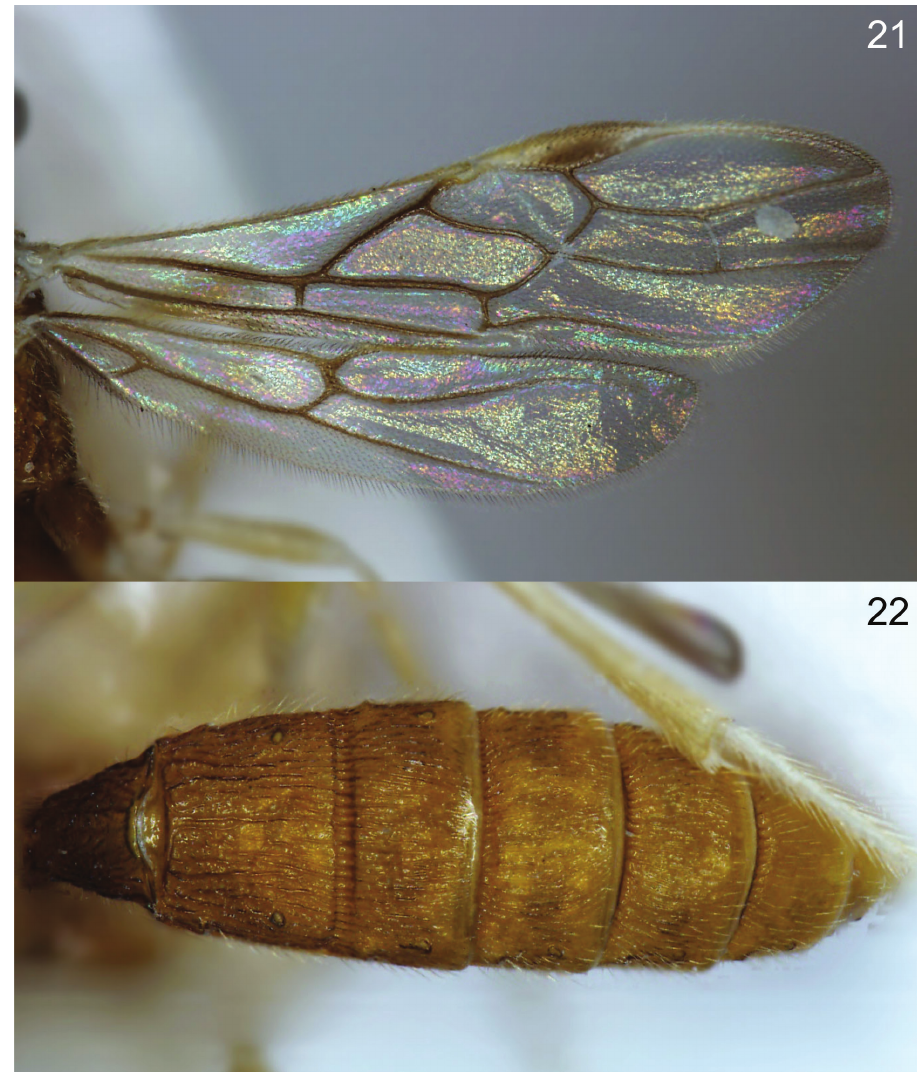
Head . Antenna with 35–39 flagellomeres. Terminal flagellomere acuminate. Me- dian flagellomeres 2.3 × longer than wide. 3 rd segment of maxillary palp of female slender, approximately 7 longer than maximally wide. 5 th segment slender and approxi- mately same length of 6 th . Base of mandible well separated from eye, closest point approximately 1.1 distance from middle of anterior tentorial pit and eye. Distance